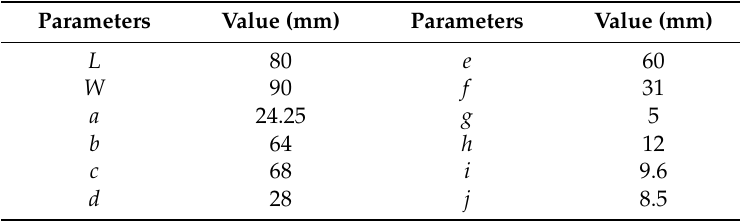
Figure 4. Parametric study of the gap between patch and ground plane; the gap cannot be increased randomly because of the design constraint of the satellite structure. Table 1. Antenna design